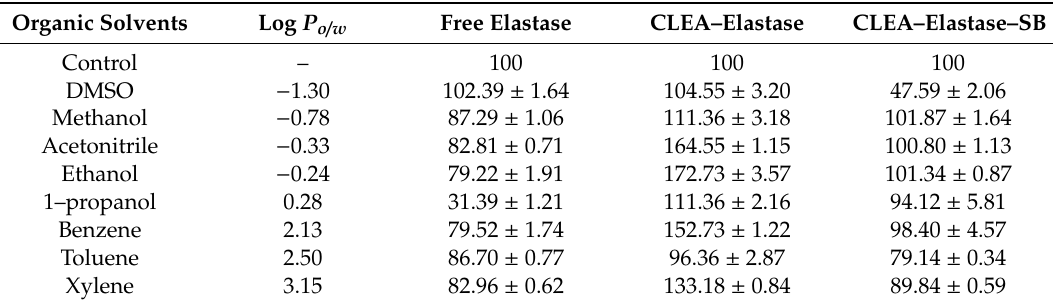
Table 1. Stability of free elastase and CLEA–elastase derivatives in 25% ( v / v ) organic solvents for 30 min represented using relative activity (%). Enzyme activity without organic solvent treatment was taken to be 100%. The experiment was conducted in triplicate and recovered activities are presented as mean values ± standard error.